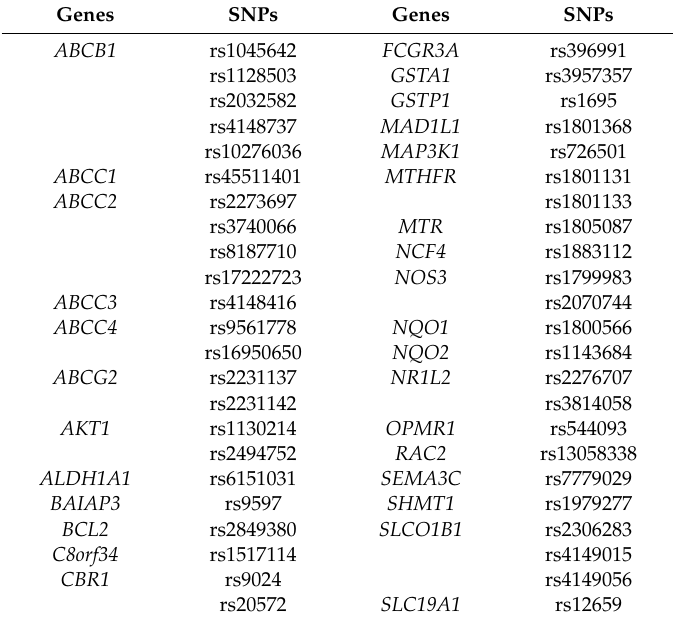
Table 4. SNPs ( n = 96) evaluated in the study cohort and genes where they are located.